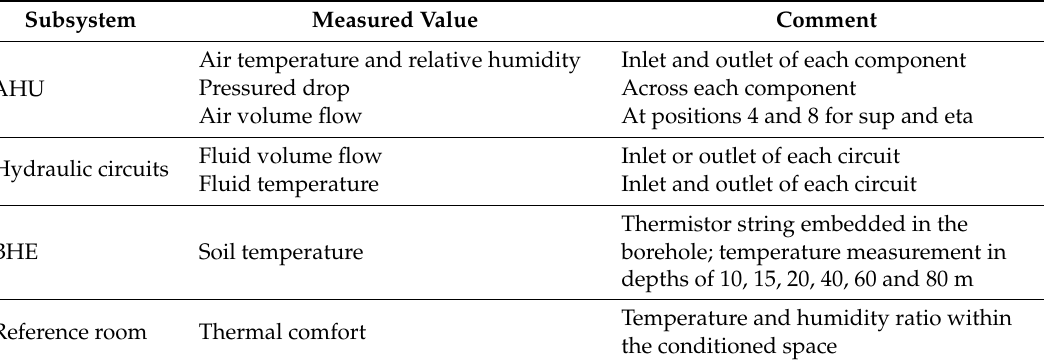
Table 1. Data acquisition concept for the entire system separated by subsystems.